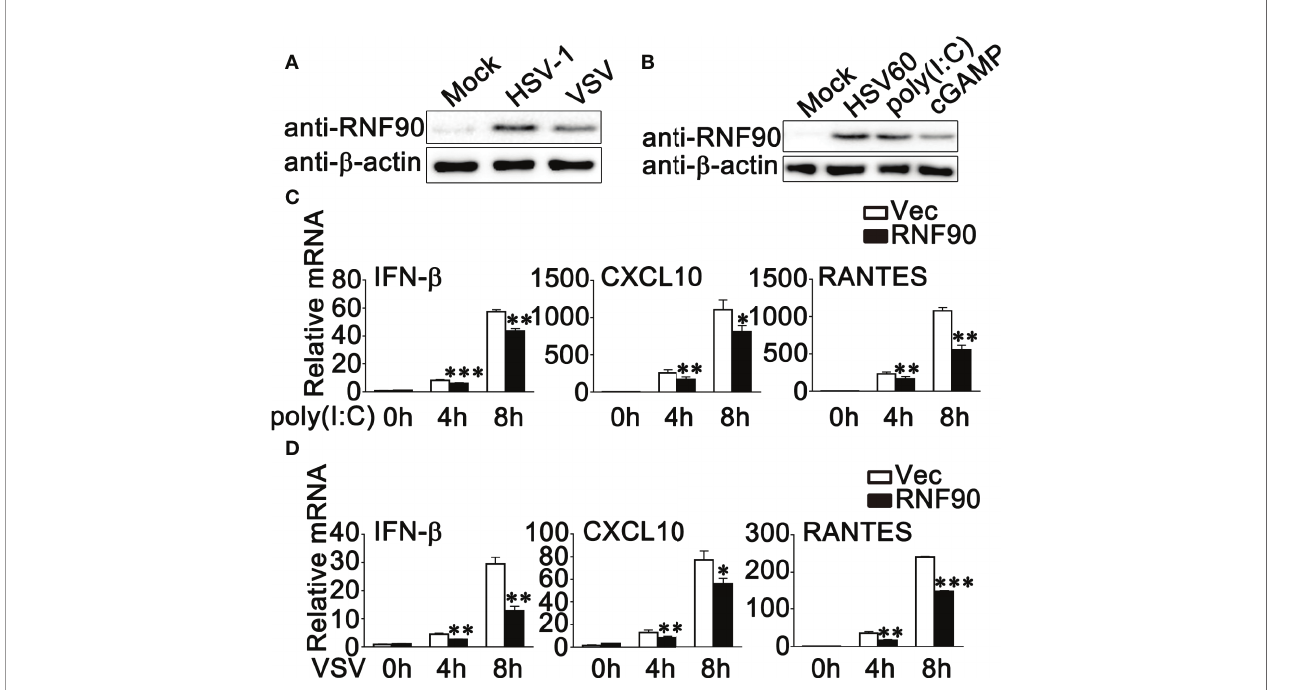
FIGURE 1 | RNF90 overexpression inhibits RNA virus-triggered innate immune responses. (A) PMA-THP1 cells were stimulated with HSV-1 (MOI = 1) or VSV (MOI = 1) for 8 h. Afterwards, the cells were lysed for immunoblot assays. (B) PMA-THP1 cells were transfected with 1 m g/ml HSV60, 2.5 m g/ml poly(I:C), or 1 m g/ml cGAMP (B) for 8 h. Afterwards, the cells were lysed for immunoblot assays. (C, D) HEK293T cells were transfected with an empty vector (Vec) or RNF90 plasmid. At 24 h after transfection, HEK293T cells were treated with poly(I:C) (2.5 m g/ml) (C) or VSV (MOI = 1) (D) for indicated time periods. Then the cells were lysed for real-time PCR analysis. b -actin was used as a loading control in all the immunoblot assays. The data are representative of three independent experiments and are presented as mean ± SEM. * P < 0.05, ** P < 0.01, *** P <